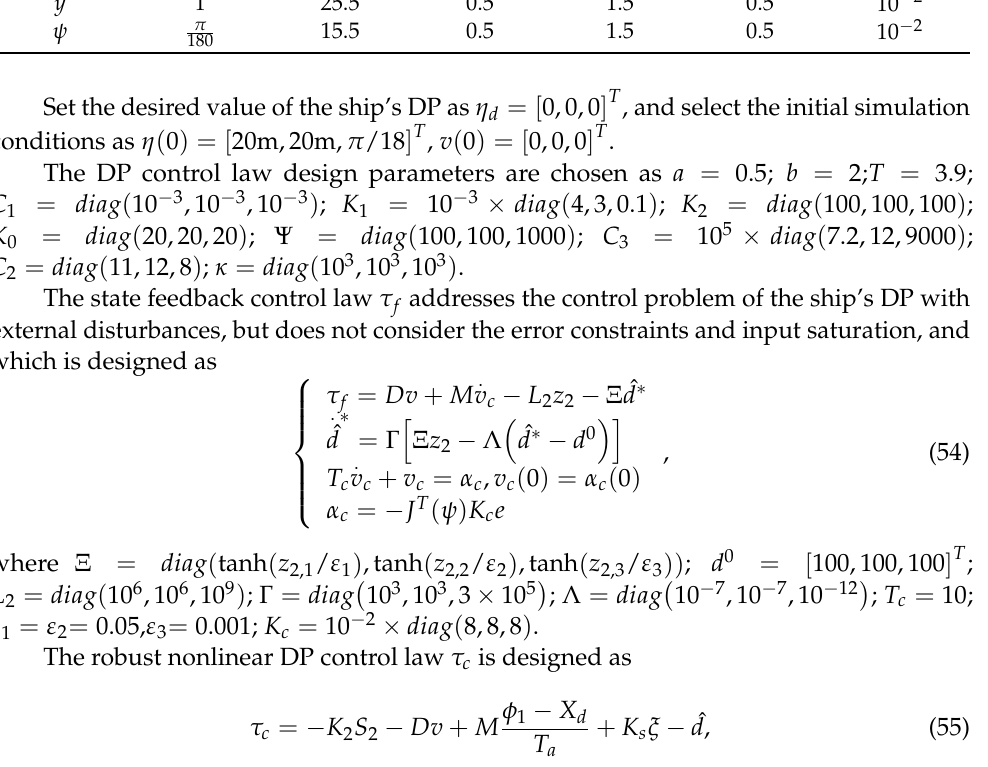
Table 1. The design parameters of ρ M , k ( t ) , ρ m , k ( t ) . ffi k æ M , k ( 0 ) æ M , k ( ∞ ) æ m , k ( 0 ) æ m , k ( ∞ ) ¯ k x 1 25.5 0.5 1.5 0.5 10 − 2 y 1 25.5 0.5 1.5 0.5 10 − 2 ψ π 15.5 0.5 1.5 0.5 10 − 180